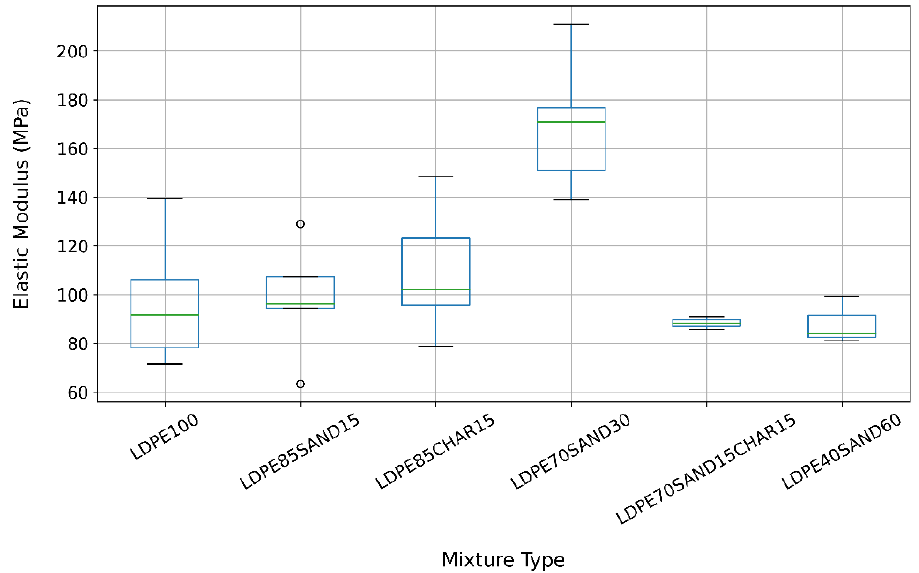
Figure 7. Elastic modulus (MPa) obtained for different mixture using tensile strength test.